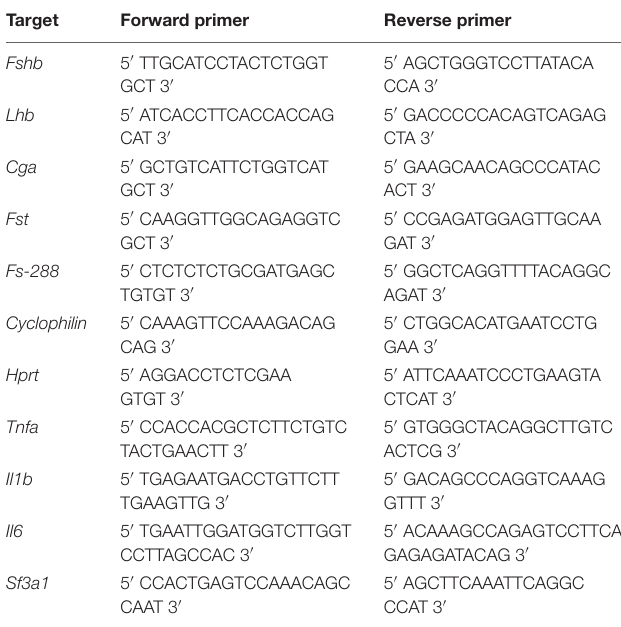
TABLE 1 | Oligonucleotide primer sequences used for real-time PCR performed on primary anterior pituitary, L β T2 cells or lung. Fshb , Lhb , Cga , Fst , Fs-288, Hprt , Cyclophilin , Tnfa , Il1b , Il6 and Sf3a1